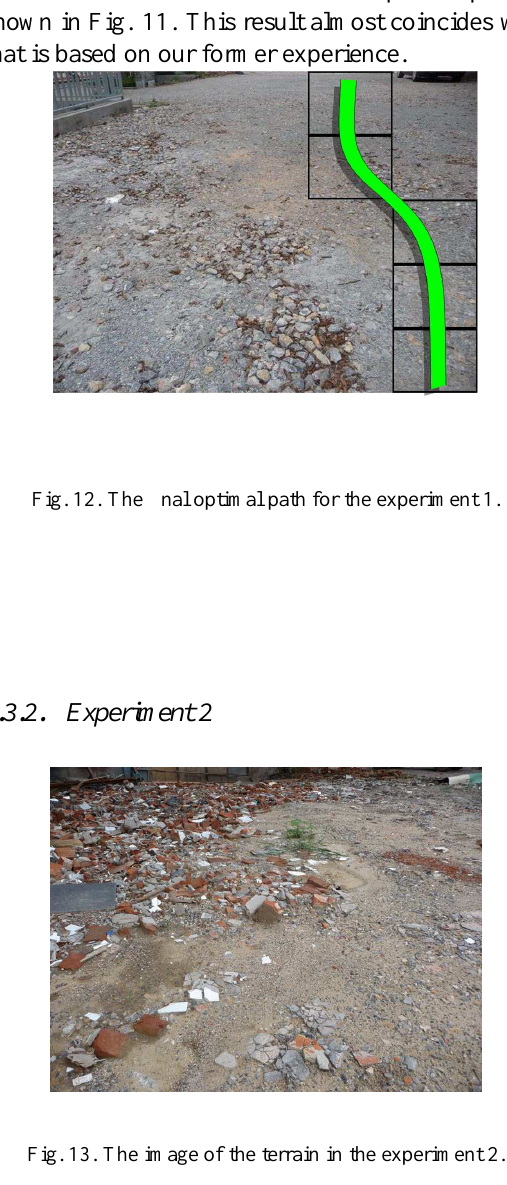
Fig. 13. The image of the terrain in the experiment